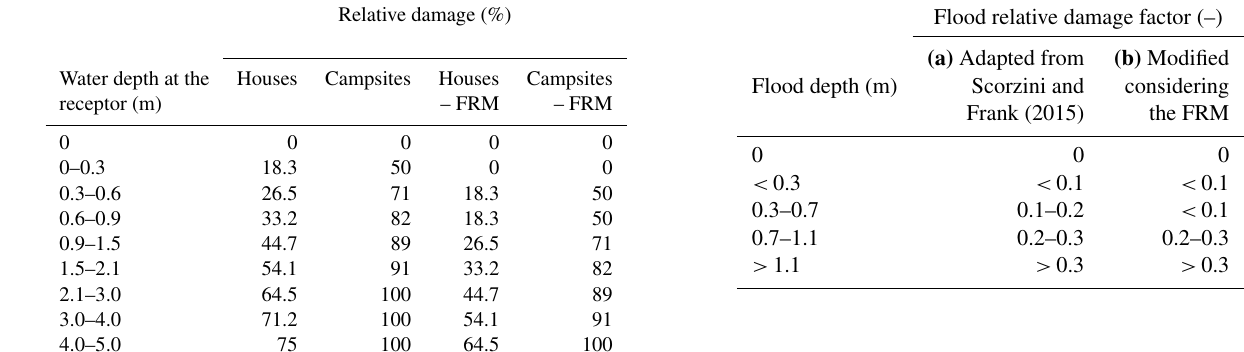
Table 3. Vulnerability relations for houses and campsite elements at the Tordera Delta study site with and without flood resilience measures (FRM).